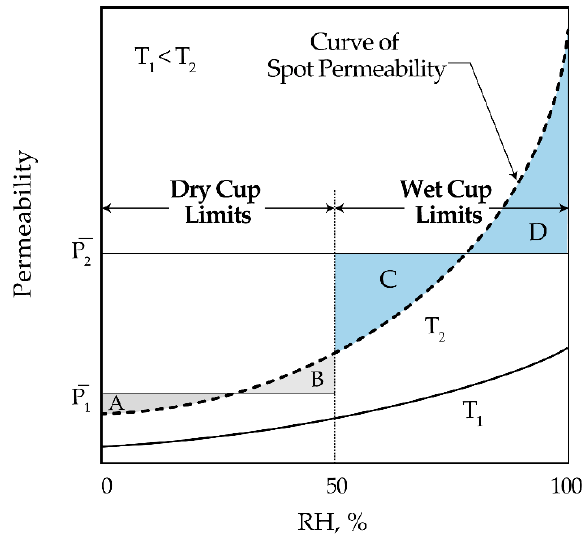
Figure 1. Variability of the spot permeability with water vapor concentration for WVT tests. Weight changes of the cups after exposure to a controlled RH at a constant temperature are then measured, which result in average permeability values. It is possible, however, to construct a spot permeability curve based on average permeability values and RH limits that generates equal areas between the curve and the limits—i.e., the dotted curve in Figure 1 has been plotted based on P 1 and P 2 from dry and wet cup tests, respectively ( area A = area B and area C = area D ) [67,75]. The resulting spot permeability curve can then be a dependable reference to determine average permeability between two individual humidity limits across the coating film. For example, to determine P across an applied coating film at 65% RH from the spot permeability curve in Figure 1, one can find a horizontal line between 0 and 65% RH where equal areas between the curve and these limits are